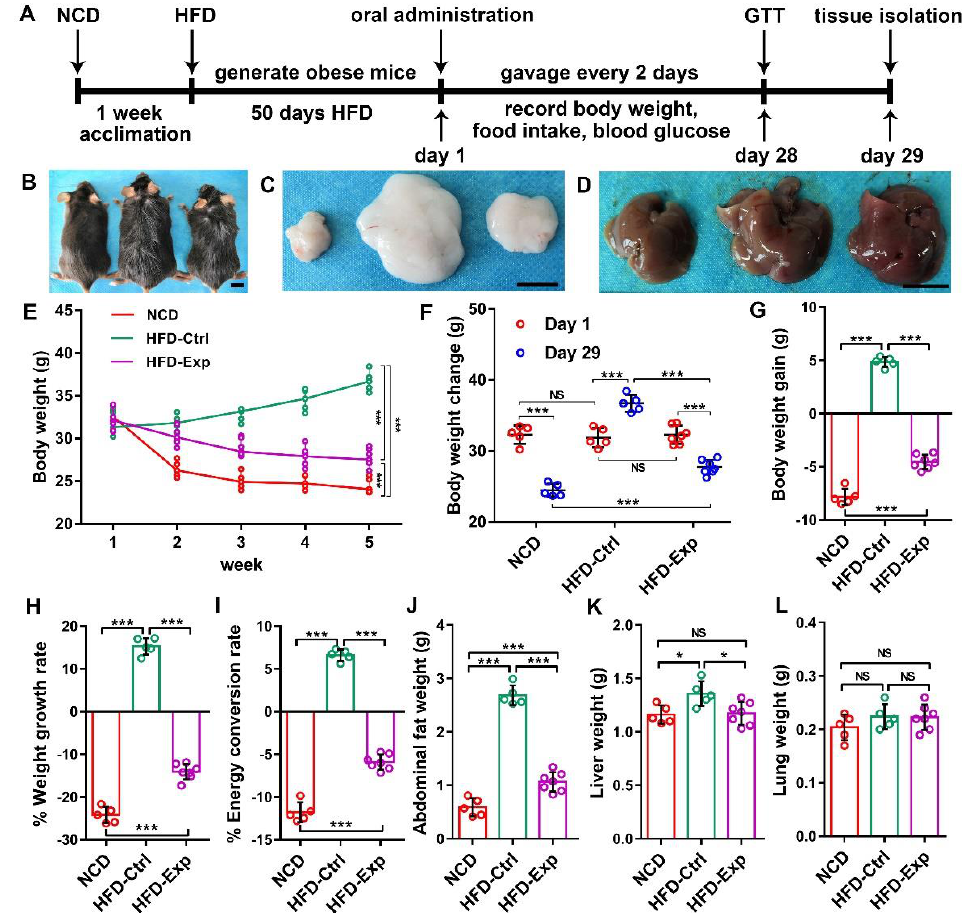
Figure 3. IL-1 β shRNA/yeast regulated body weight via oral route in vivo. ( A ) Timeline of mice processing. Morphological differences of mice body type ( B ), abdominal fat ( C ) and liver ( D ) (Scale = 1 cm). From left to right, it refers to group NCD, HFD-Ctrl and HFD-Exp respectively. ( E , F ) Body weight changes from day 1 to day 29. Net weight gain ( G ) and net weight growth rate ( H ) of mice from day 1 to day 29. ( I ) Energy conversion rate (%). ( J ) Abdominal fat weight. ( K ) Liver weight. ( L ) Lung weight. NS (no significance). * p < 0.05, *** p < 0.001 ( n = 5 or 7).